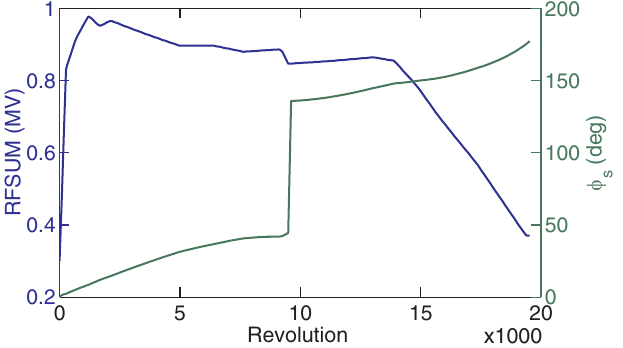
FIG. 14. (Color) The rf voltage V (RFSUM) and the synchro- recorded with console program during this nous phase (cid:10) s